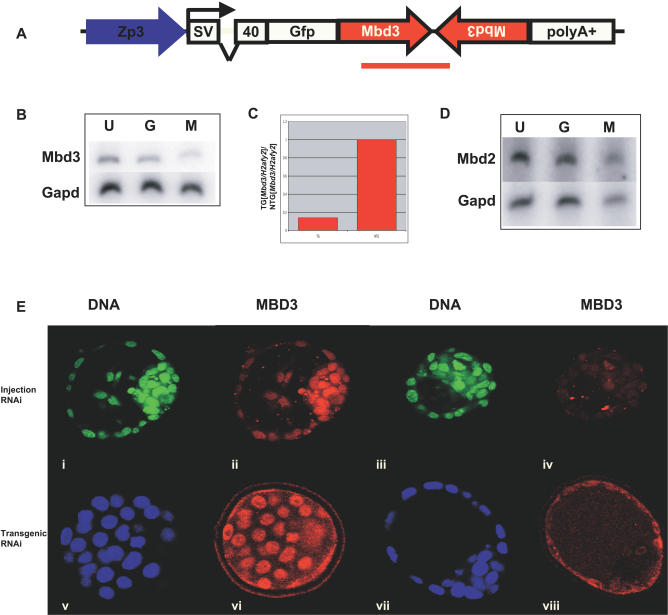
Mbd3 RNA and Protein Are Specifically Reduced in RNAi-Treated Embryos(A) A schematic depicting the RNAi transgene showing the Zp3 promoter driving expression of Gfp and the Mbd3 inverted repeat in growing oocytes. The dsRNA used in the injection RNAi experiments is designated by the red line below the inverted Mbd3 repeat and is identical to the sequence used in the TG RNAi.(B) RNA was collected from embryos injected with dsMbd3 [M], dsGfp [G], or uninjected [U], cultured for 96 h, and collected in pools of six blastocyst-stage embryos. The RNA was used for quantitative RT-PCR. When normalized to Gapd RNA levels and compared to uninjected and dsGfp-injected control embryos, dsMbd3-injected embryos show reduced levels of RNA. The embryos shown have only 24% of the Mbd3 RNA compared to uninjected embryos. RNA from TG and NTG GV stage oocytes was also used for quantitative RT-PCR.(C) A graphical representation of real-time quantitative RT-PCR experiments demonstrating reduced Mbd3 RNA levels in TG oocytes. TG and NTG bars represent the ratios of Mbd3 to H2afy2 levels (a H2 histone expressed in early embryos) derived from crossing points. The ratios are normalized to the levels in NTG embryos (shown as 1), and are the averages of three experiments. TG oocytes have only 15% of the Mbd3 RNA compared to NTG oocytes.(D) RT-PCR analysis for Mbd2 demonstrates targeting specificity for Mbd3 because no reduction in Mbd2 mRNA was seen.(E) Embryos were subjected to immunocytochemistry with the anti-MBD3 antibody as described in Figure 1B. MBD3 protein levels are greatly reduced in both dsMbd3 injected embryos (iv) and TG embryos (viii) when compared to dsGfp injected (ii) and NTG (vi) controls. Embryos were also treated with SytoX (i, iii) or DAPI (v, vii) to show the nuclei of the embryos. DsGfp injected embryos are shown in i, ii; dsMbd3 injected embryos are shown in iii, iv; with NTG (v, vi) and TG blastocysts (vii, viii) shown in the bottom panels.